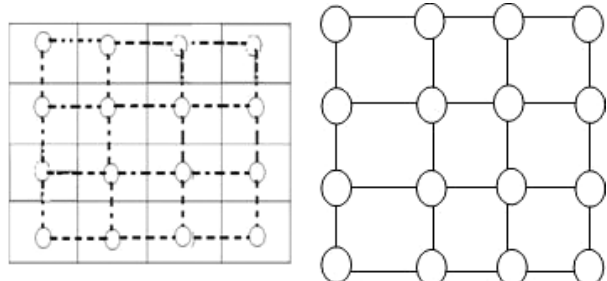
Fig. 2. 4 (cid:1) 4 Micro°uidic array represented as 4 (cid:1) 4 matrix or Graph.